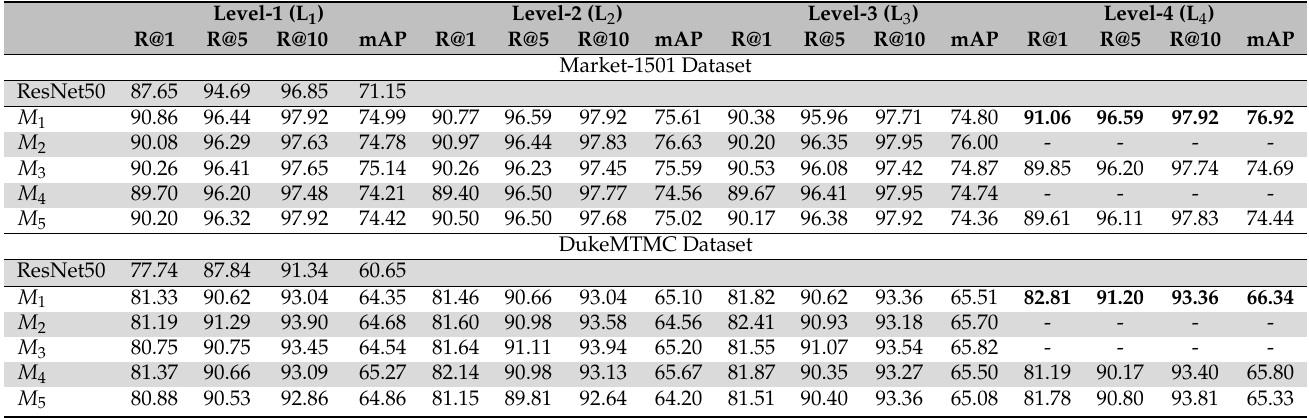
Table 1. Residual Transformers (RTr) performance against baseline (ResNet50) trained and evaluated on Market-1501 [39] and DukeMTMC [40] datasets. The best results are in bold, and “-” represents that the network did not converge in the given number of epochs. The “Levels” represent the presence of transformers after that block, while the subscript of “M” means the number of transformers after each block. The number of heads “h” is four throughout the experiments.